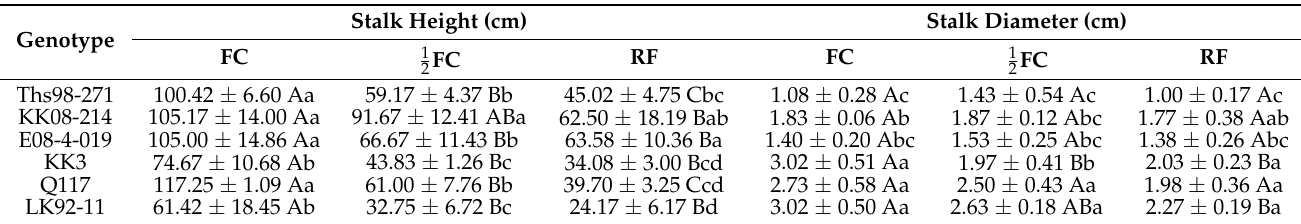
Table 2. Stalk height and diameter of six sugarcane genotypes under early drought conditions (determined four months after